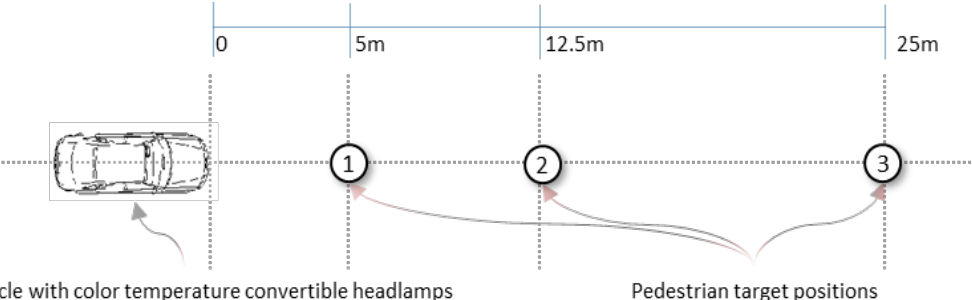
Figure 6. Pedestrian target position.